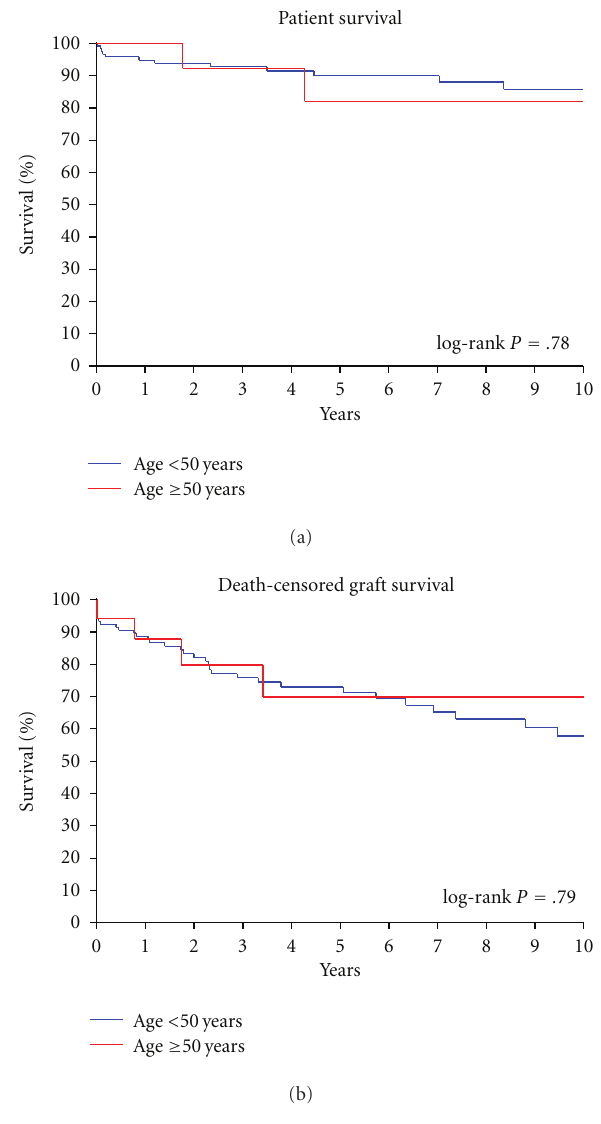
Figure 2: Kaplan-Meier survival curves. The overall patient survival is depicted in (a), while the death-censored graft survival is depicted in (b). Survival curves were calculated using the Kaplan-Meier method. Patient and death-censored graftsurvival rates were similar between the two groups (log-rank P = . 78 & log-rank P = . 79, resp.). The median follow-up time was 5.1 years in the < 50 years of age group and 4.3 years in the ≥ 50 years of age